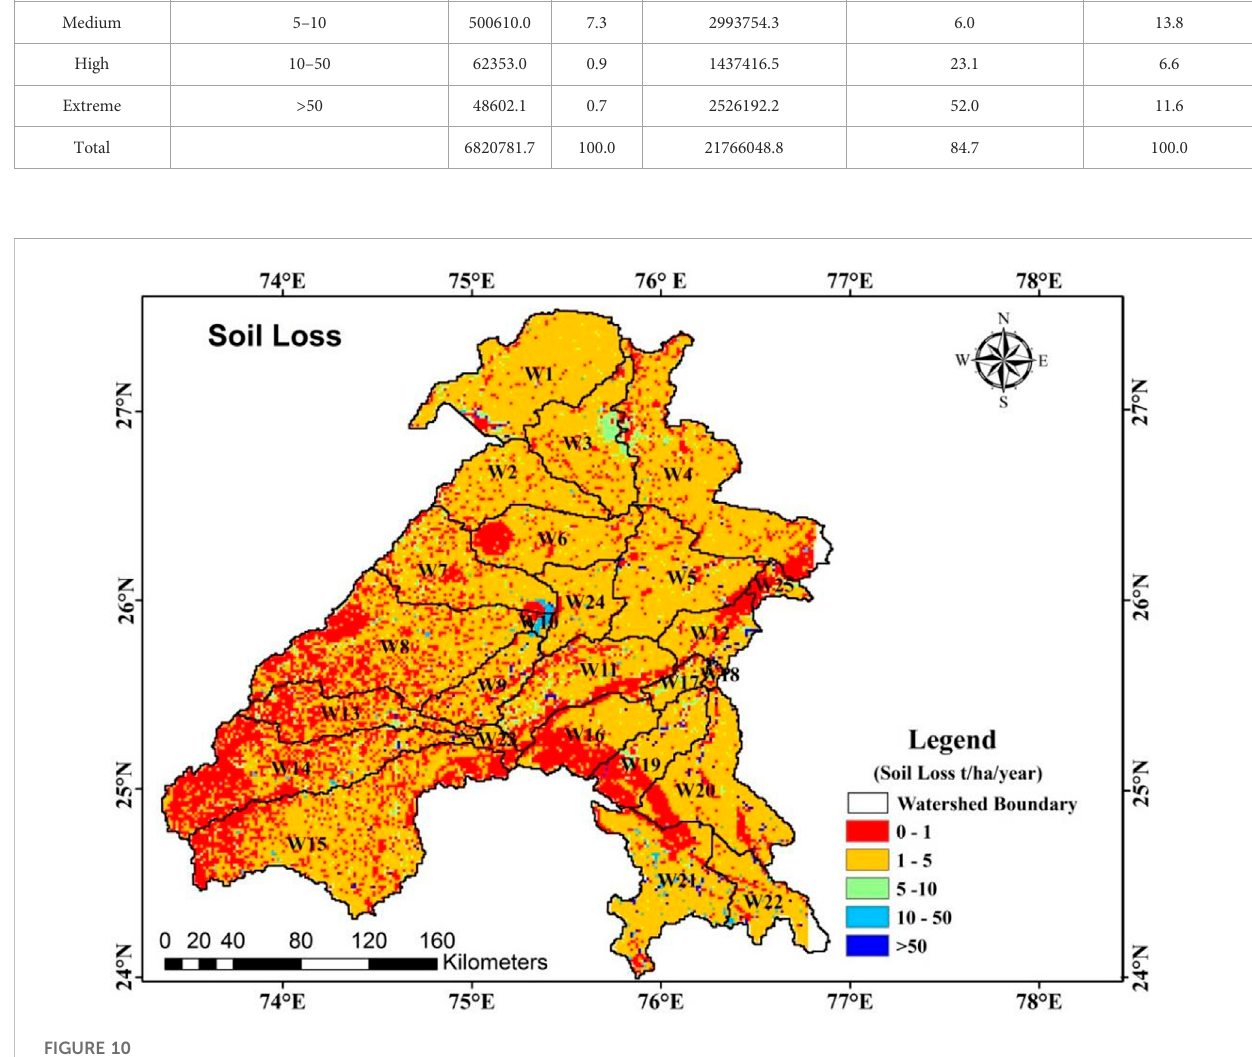
Soil loss map of the